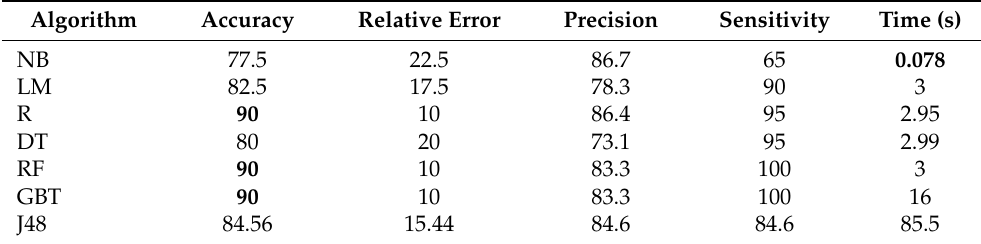
Table 5. Comparison between different algorithms applied on preprocessed heart disease data.